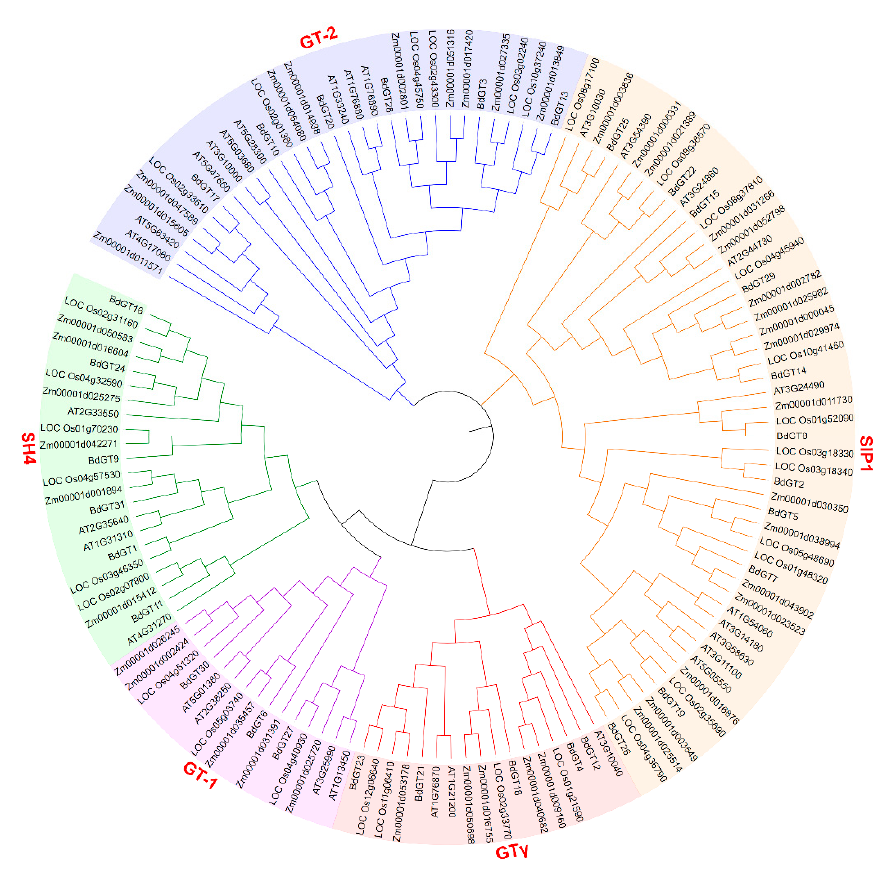
Figure 4. Phylogenetic analysis of Arabidopsis , maize, rice, and B. distachyon GT factors.